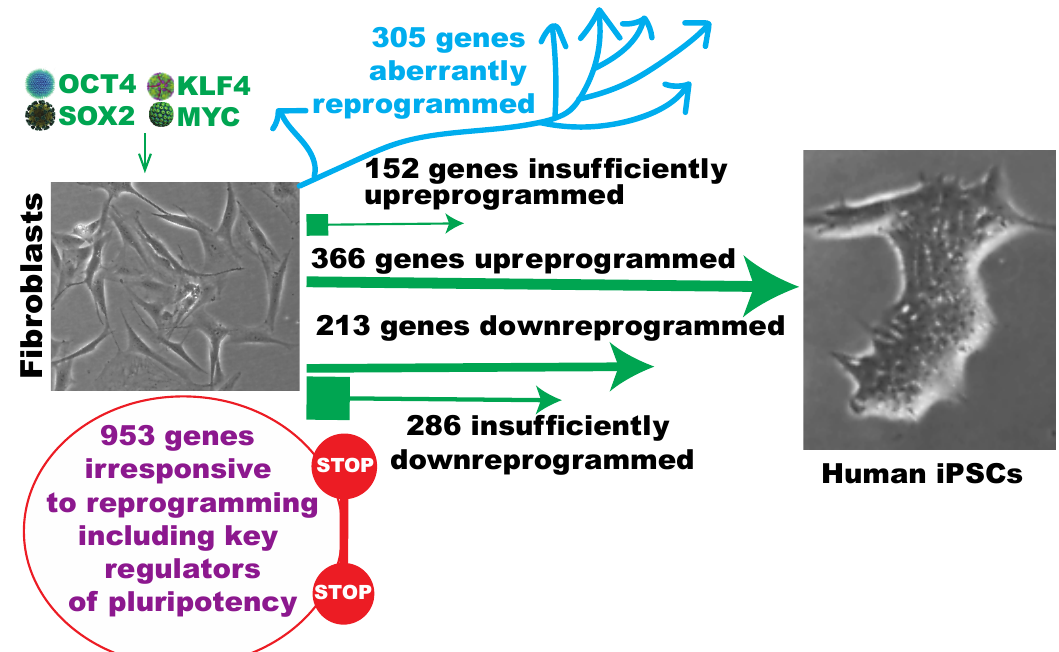
Figure 9. A model for molecular underpinnings of, and resistance to, as well as derailing of Yamanaka reprogramming of human fibroblasts. Green arrows towards the iPSC images indicate positive responses, and the squares at the end of the arrows indicate the reprogramming traction. Cyan arrows away from the iPSC images indicate molecular derailing of reprogramming. Stop signs denote refractory genes of reprogramming as members of the reprogramome.